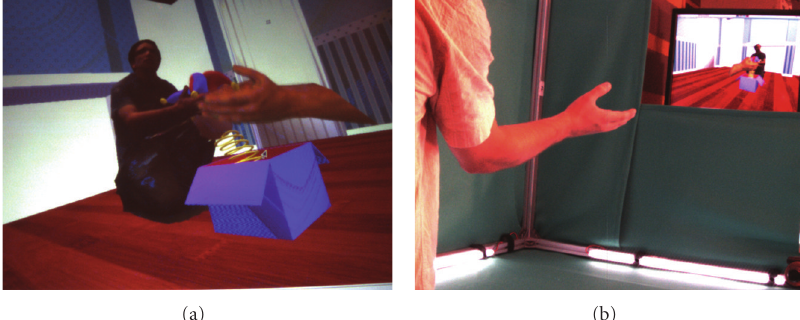
Figure 10: (a) the 3D virtual environment with a “full-body” user and a “hand” user, interacting together with a virtual puppet, and (b) the “hand-size” acquisition